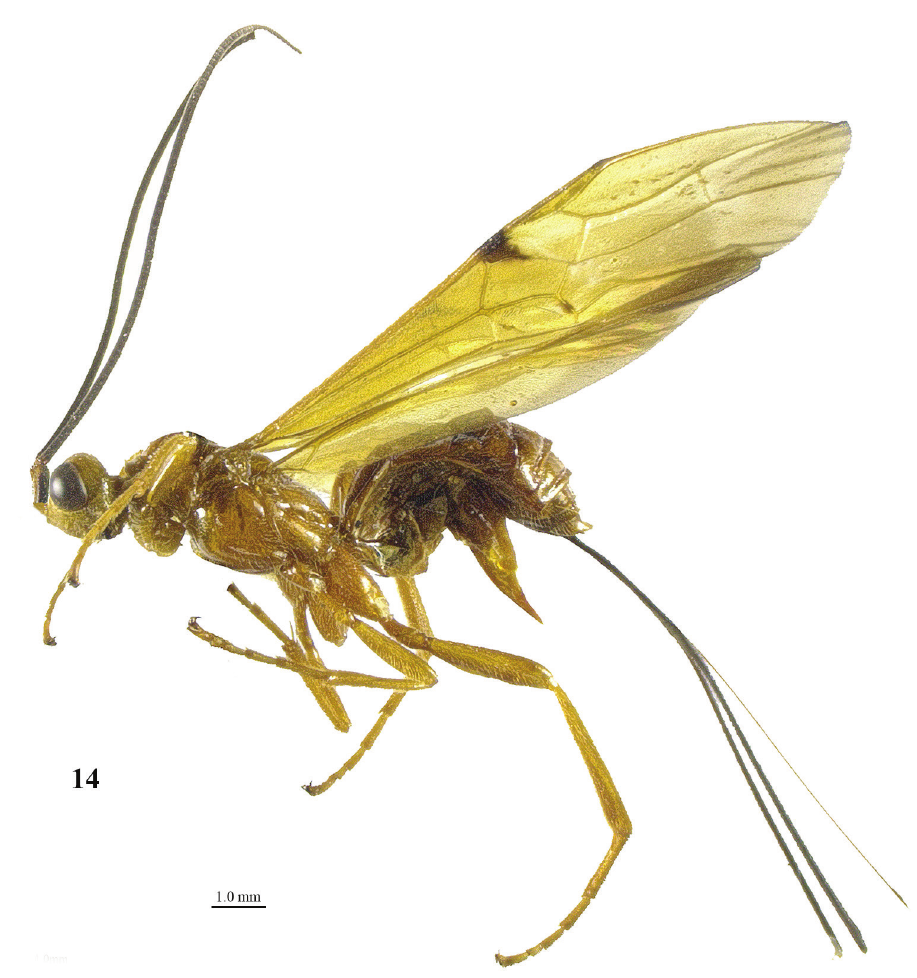
Figure 14. Craspedolcus fraternus Enderlein, ♀ , China (Yunnan), habitus lateral.